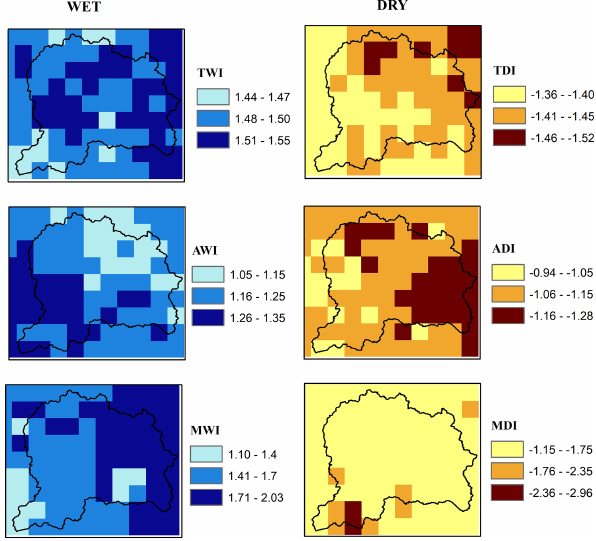
Figure 4. Spatial distribution of total wet duration (TWD), total dry duration (TDD), average wet duration (AWD), average dry duration (ADD), maximum wet duration (MWD), and maximum dry dura- tion (MDD) for the period 1981–2014.